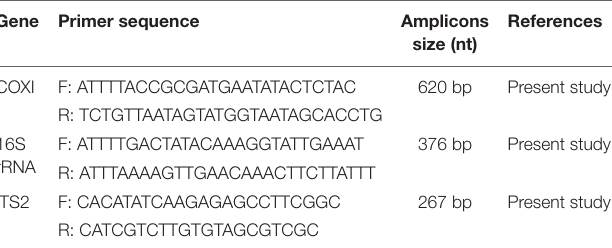
TABLE 1 | Primers used for the amplification of target partial genes of R.